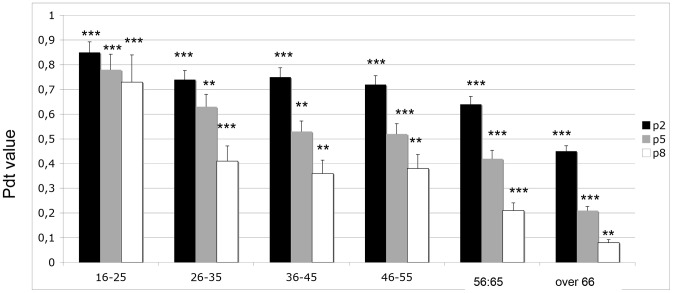
Population doubling time (PDT) of DPSCs cultured in the presence of basal culture medium for undifferentiated DPSCs.The graph shows in vitro passage (starting from p2 for young cells (black bar) to p8 (white bar)) and the age of the donor (from 16 to over 67). T tests were used to determine significant differences (p<0.05). * p<0,05; * * p<0,01; * * * p<0,001.